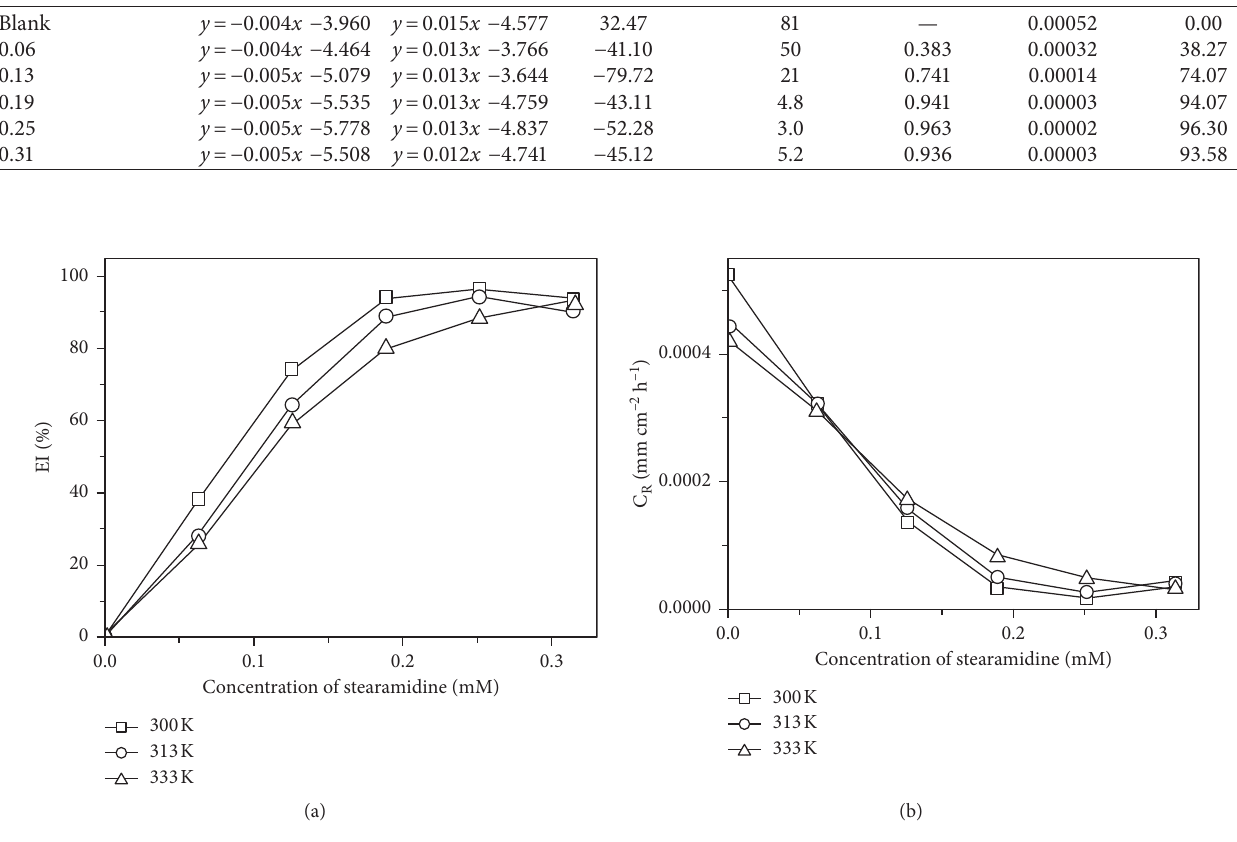
Table 1: Electrochemical parameters of Cu in 3.0 wt.% NaCl solution at 300K with various concentrations of stearamidine. Stearamidine (mM)